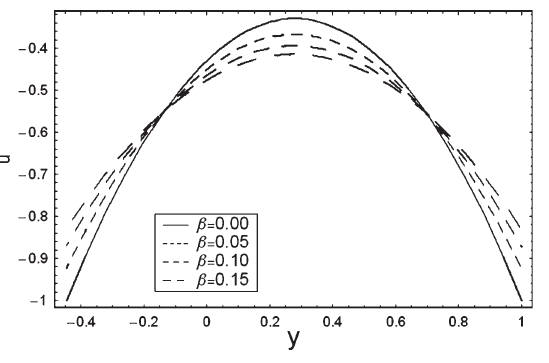
Fig. 12. Effect of slip parameter β on the variation of longitudinal velocity u plotted for a = 0 . 2, b = 0 . 5, d = 0 . 8, (cid:15) = 0 . 01, θ = 1, x = π, α = π/ 6 , Re = 0 . 5, Fr = 1 , dp (2) /dx = 1 and φ = π/ 4 .